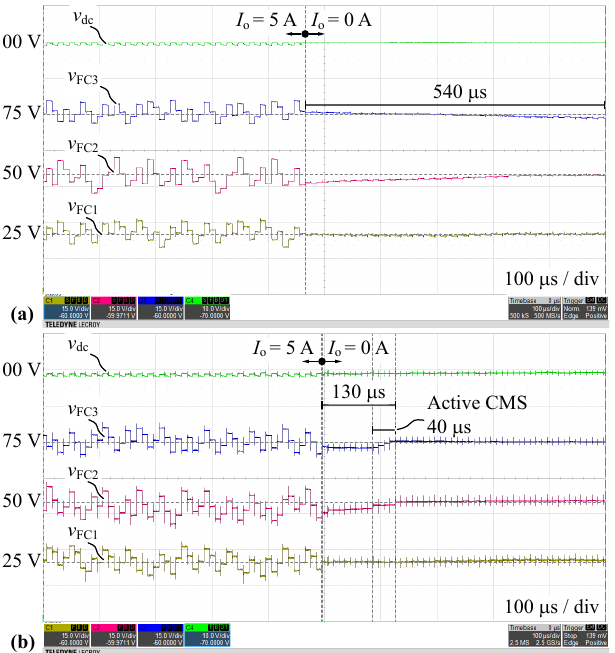
Figure 20. Comparison of measured waveforms (DC-link capacitor voltage v dc , FC voltages v FC{1,2,3} ) for Q2L-5L-FCC in a full DC-link configuration during load disconnection ( I o = 5A → 0A): ( a ) OL with resistive balancers; ( b ) CL balancing with CMS. Delay times T delay = T p = 50ns are